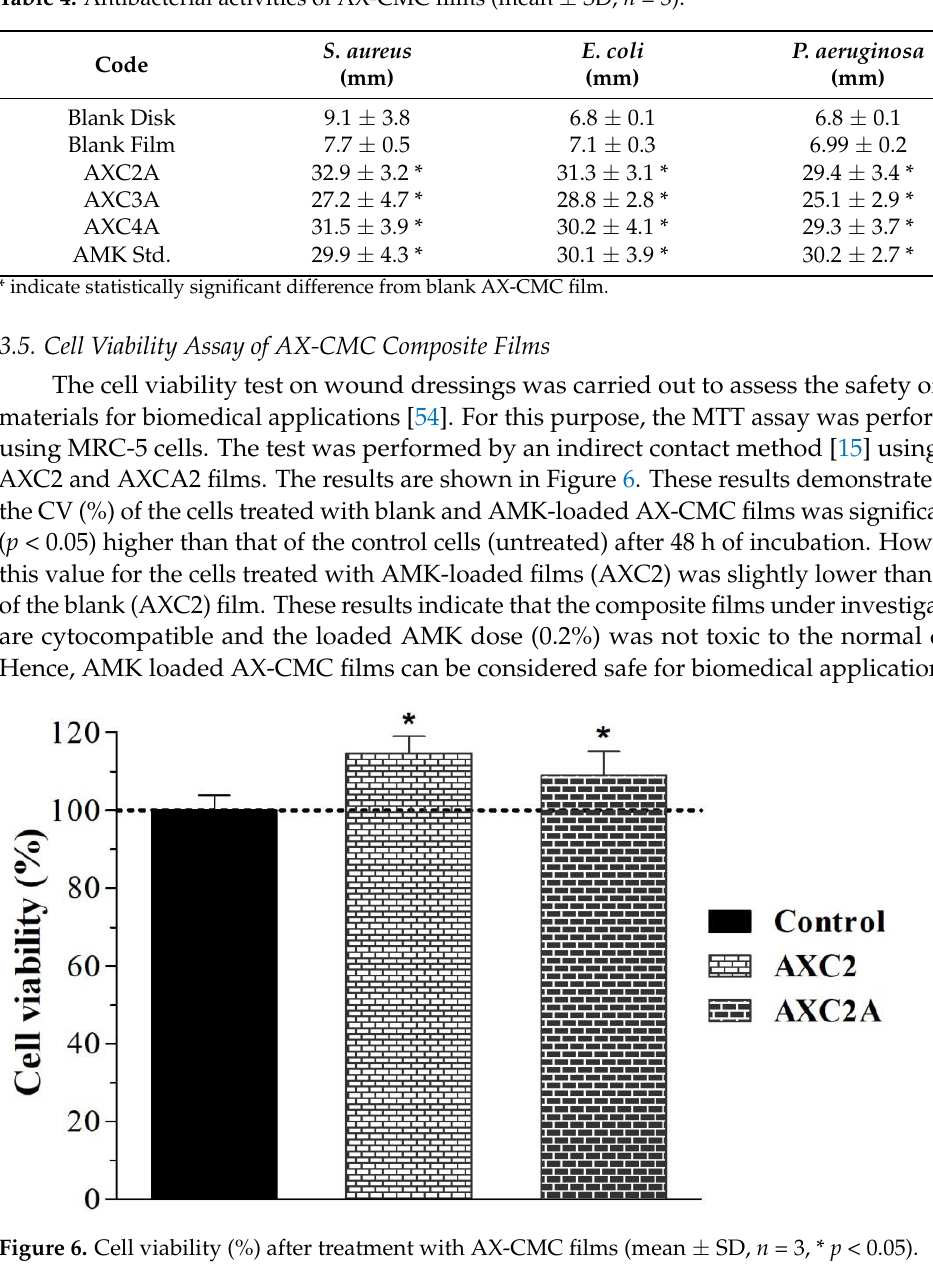
Table 4. Antibacterial activities of AX-CMC films (mean ± SD, n = 3).